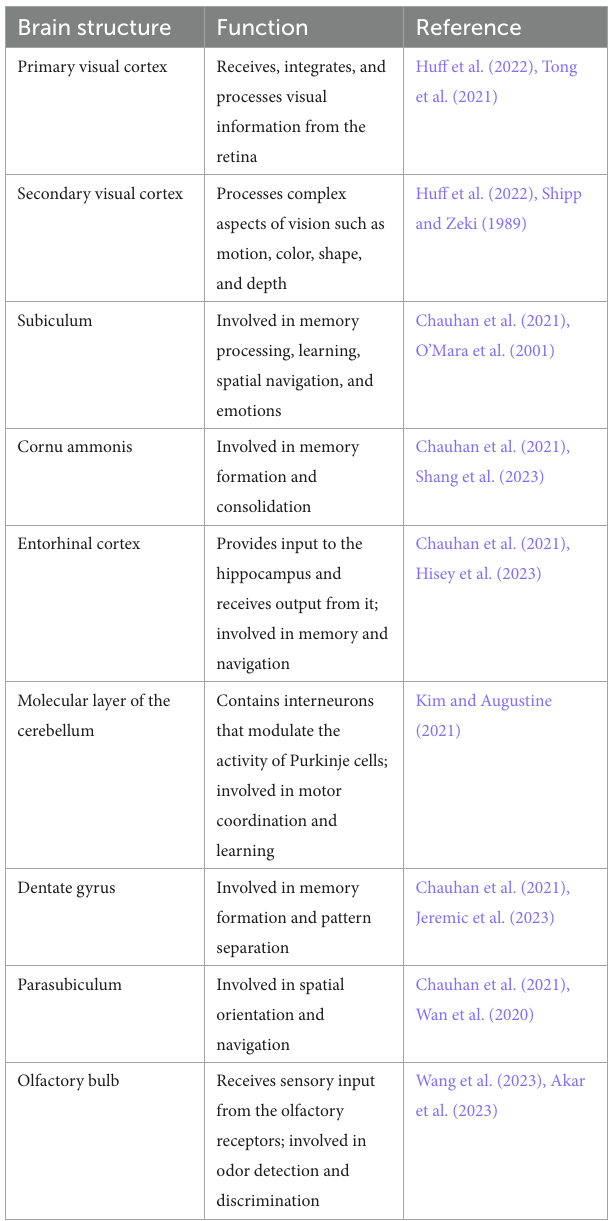
TABLE 3 The main functions of the brain regions involved in this